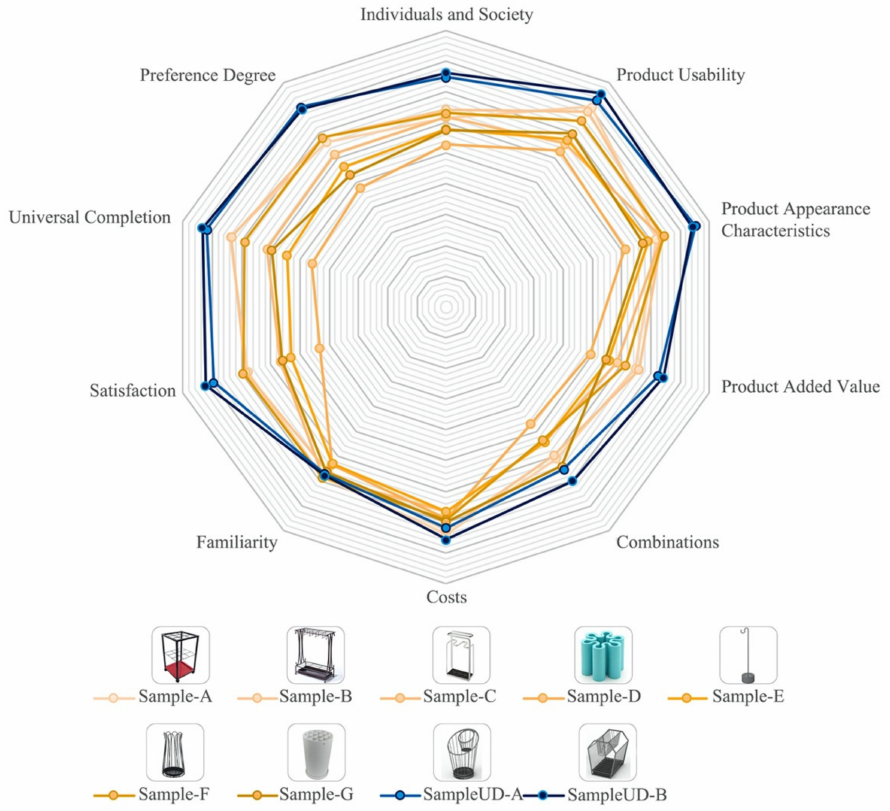
Figure 5. UD achievement of design